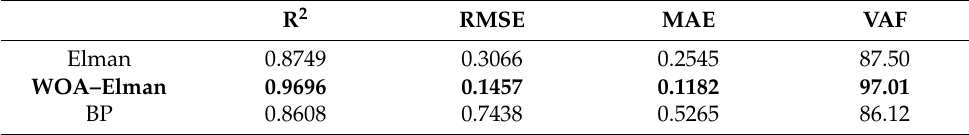
Table 3. Evaluation index values of three machine learning